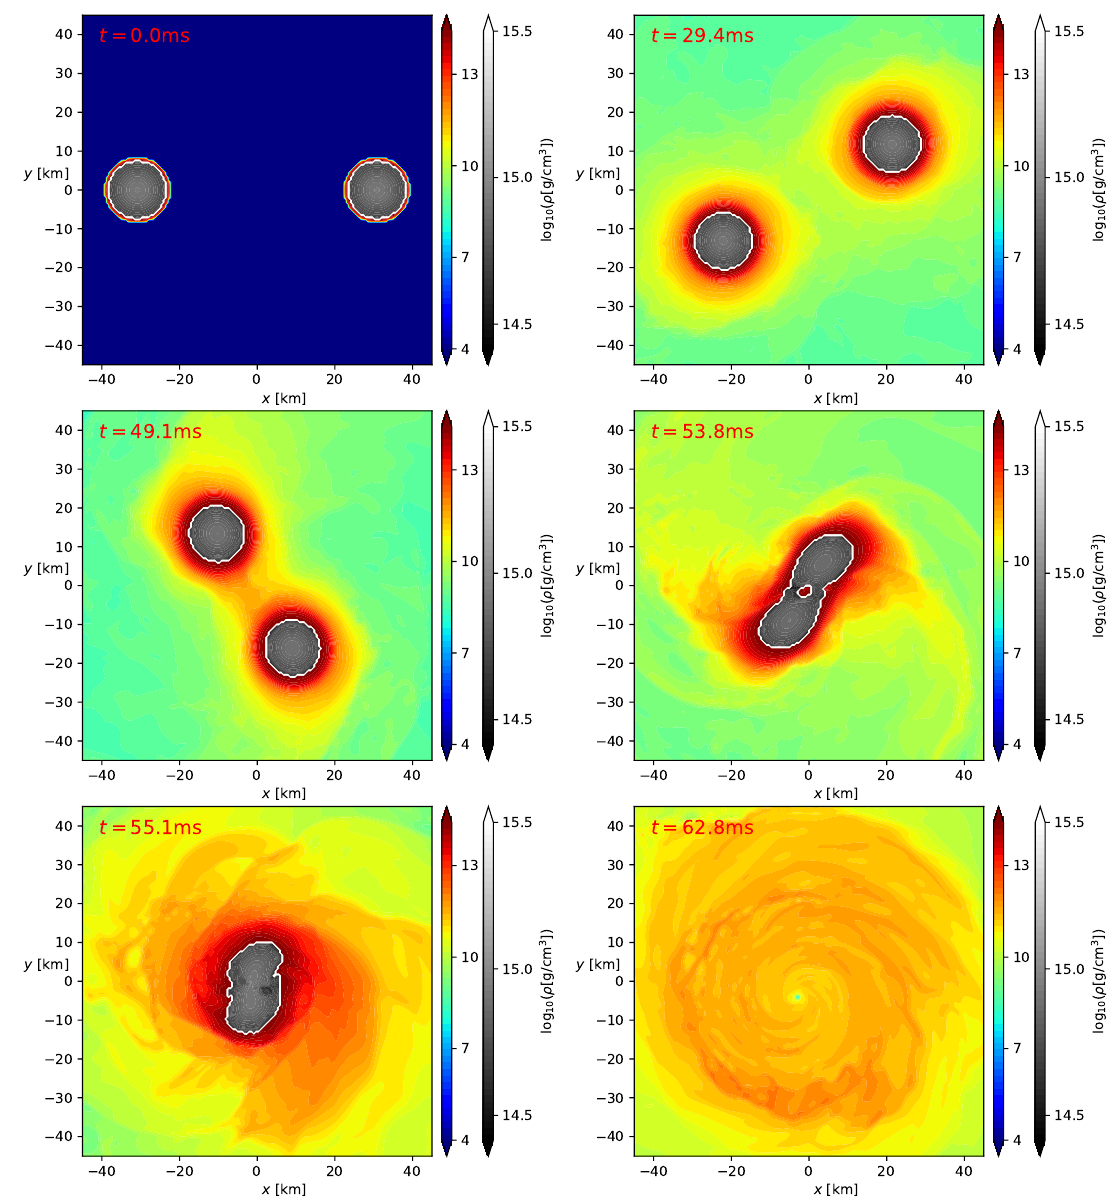
Figure 4. Density evolution within the orbital plain for different time snapshots for the R4 setup. We show the HM on a color scale ranging from blue to red and the SQM on a gray